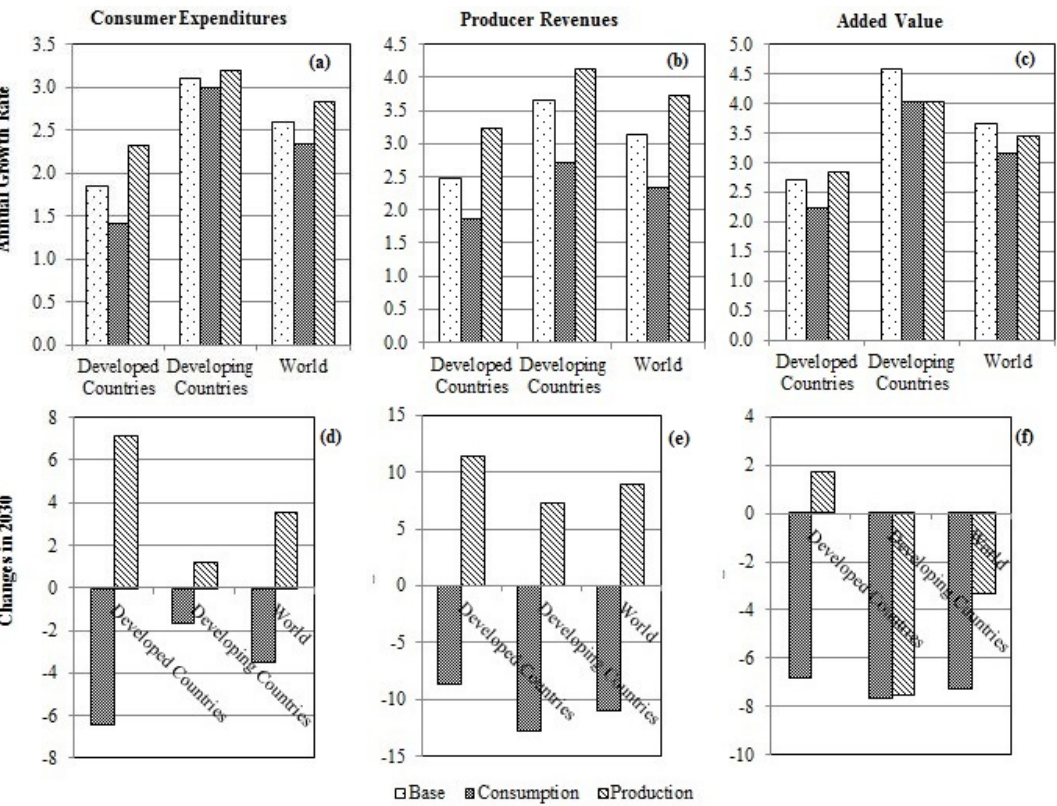
Figure 4. Annual growth rates of ( a ) consumer expenditures; ( b ) producer revenues; ( c ) added value under each scenario. Changes in ( d ) consumer expenditures; ( e ) producer revenues; ( f ) added value in 2030 under each scenario. Note: all the values are reported as percentages.